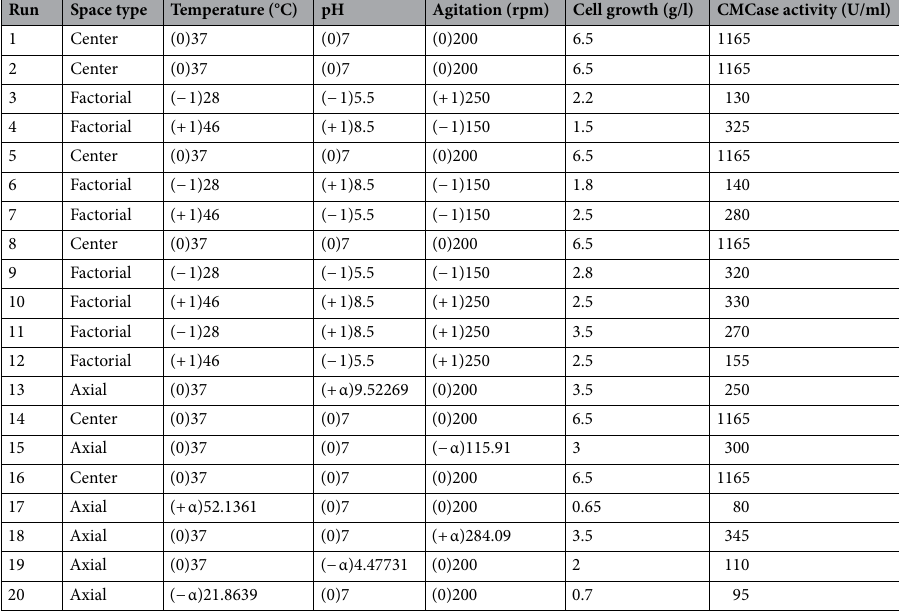
Table 2. Quadratic model predicted responses of the fermentation parameters by using central composite